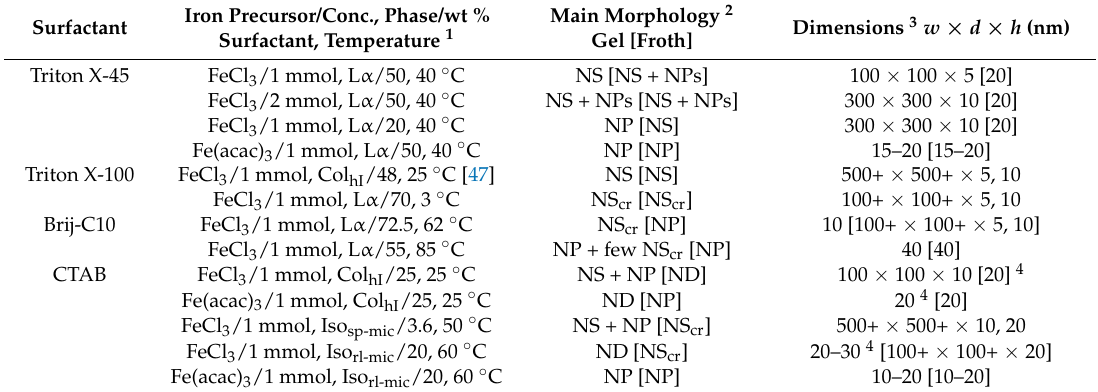
Table 1. Summary of nanostructures formed in the various micellar solutions and LLC phases.